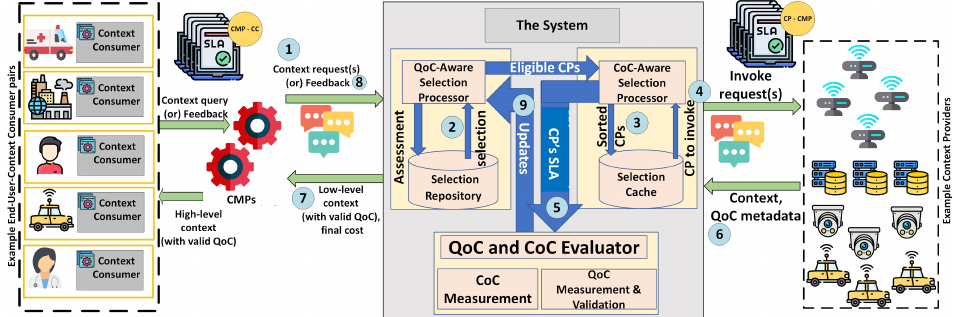
Figure 5. Data flow between the proposed system and the involved actors after deploying it in a context-aware IoT